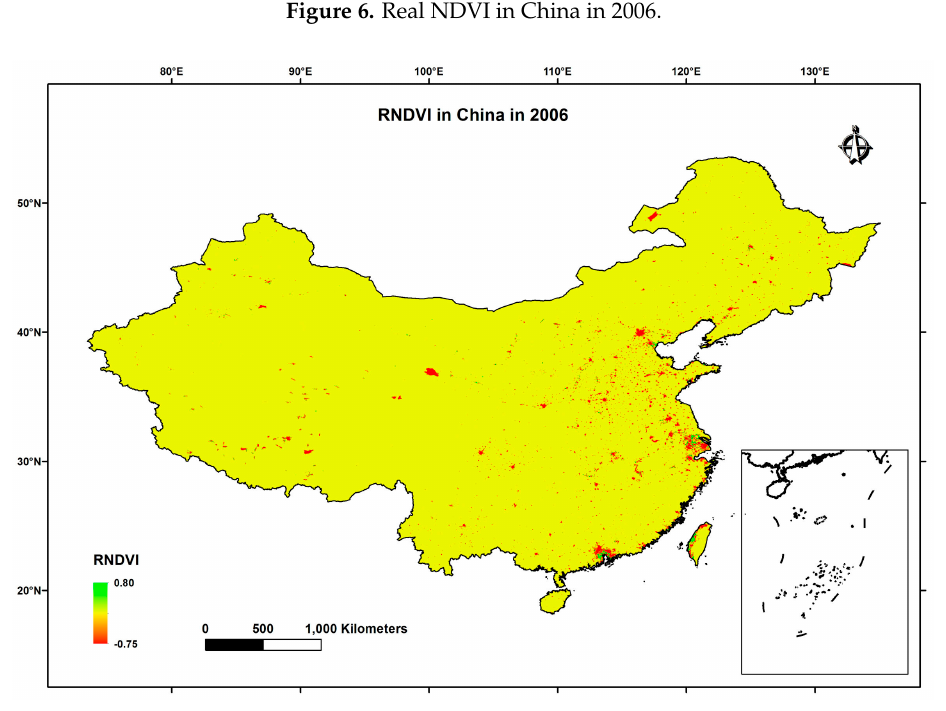
Figure 6. Real NDVI in China in 2006.